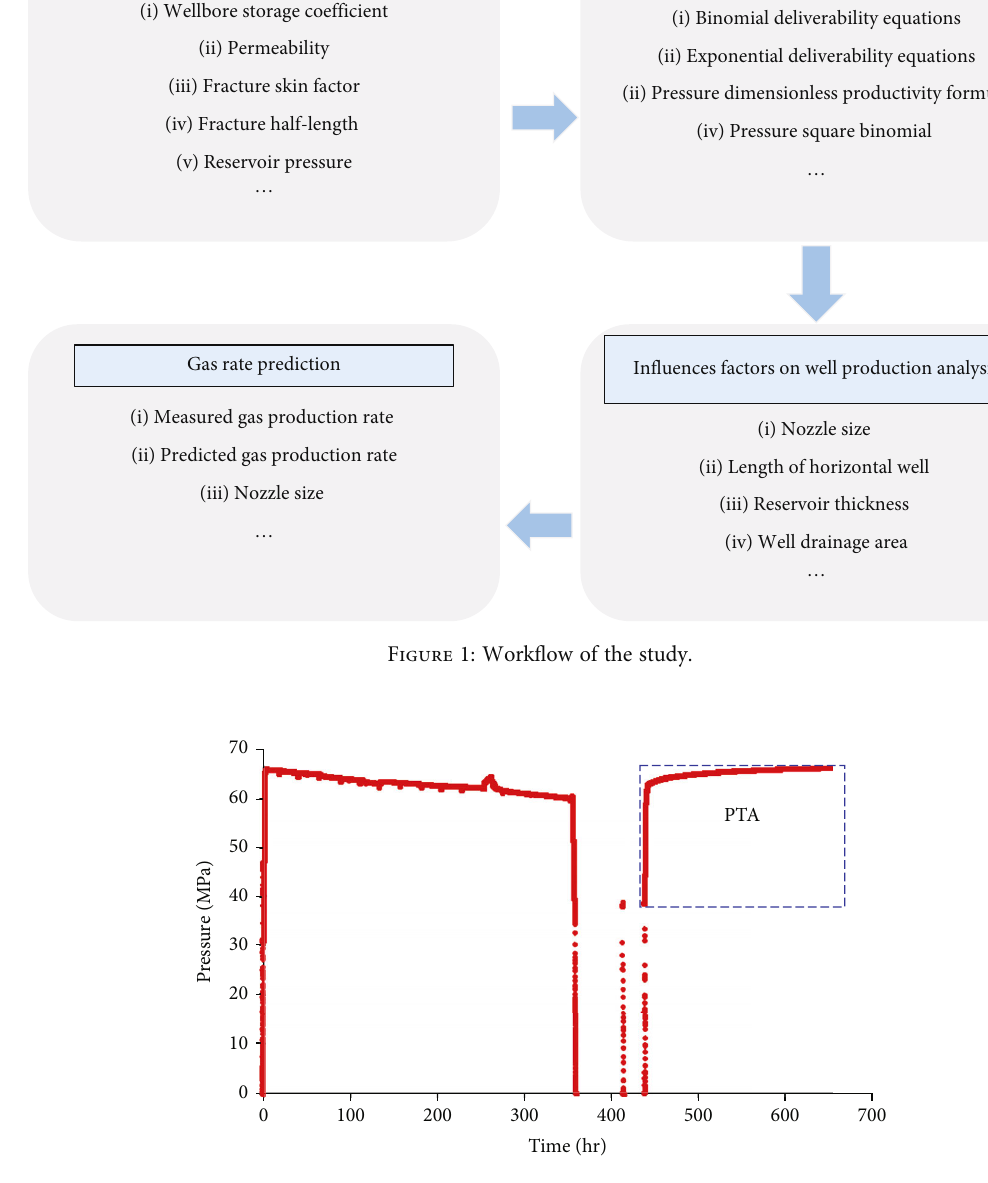
Figure 2: Pressure history of Well SX161.